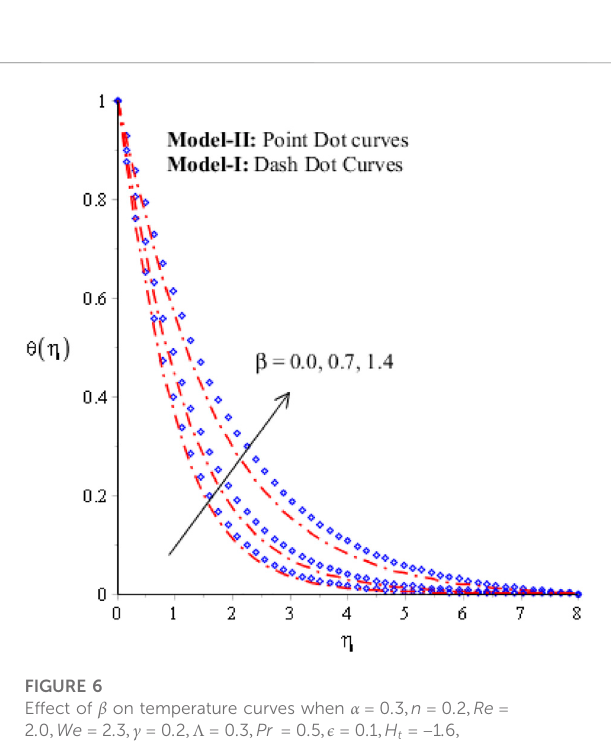
FIGURE 6 Effect of β on temperature curves when α (cid:2) 0 . 3 , n (cid:2) 0 . 2 , Re (cid:2) 2 . 0 , We (cid:2) 2 . 3 , γ (cid:2) 0 . 2 , Λ (cid:2) 0 . 3 , Pr (cid:2) 0 . 5 , ϵ (cid:2) 0 . 1 , H t (cid:2) − 1 . 6 , Sc (cid:2) 0 . 4 , λ (cid:2) 0 . 8 , K c (cid:2) − 1 . 5 , χ (cid:2) 0 . 4 , and τ (cid:2) 3 .